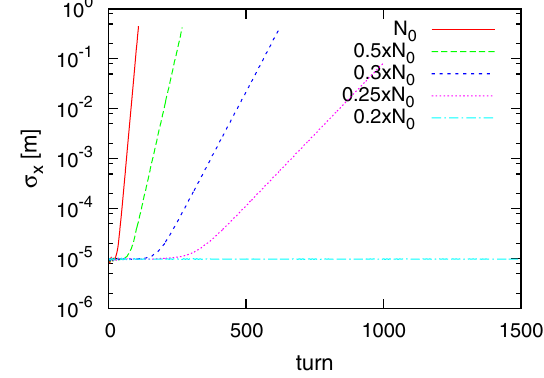
FIG. 10. Evolution of the beam size for the single beam tracking simulation including the tune shift using Eq. (11) in FCCee-Z, where θ at N 0 .